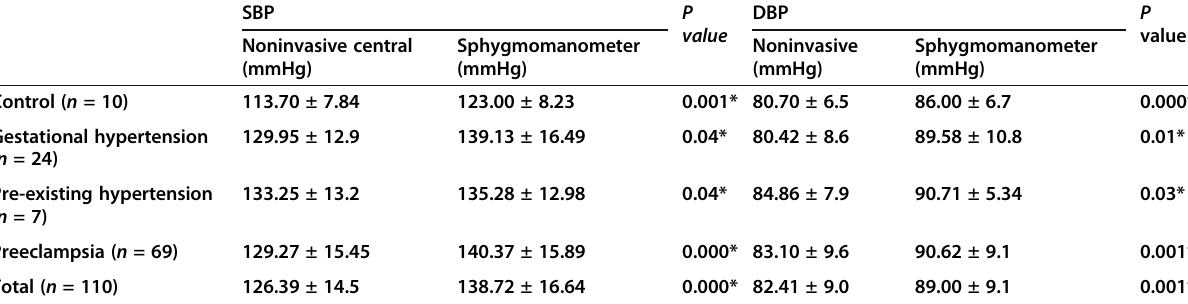
Table 3 Accuracy of peripheral sphygmomanometer against noninvasive SBP among the studied